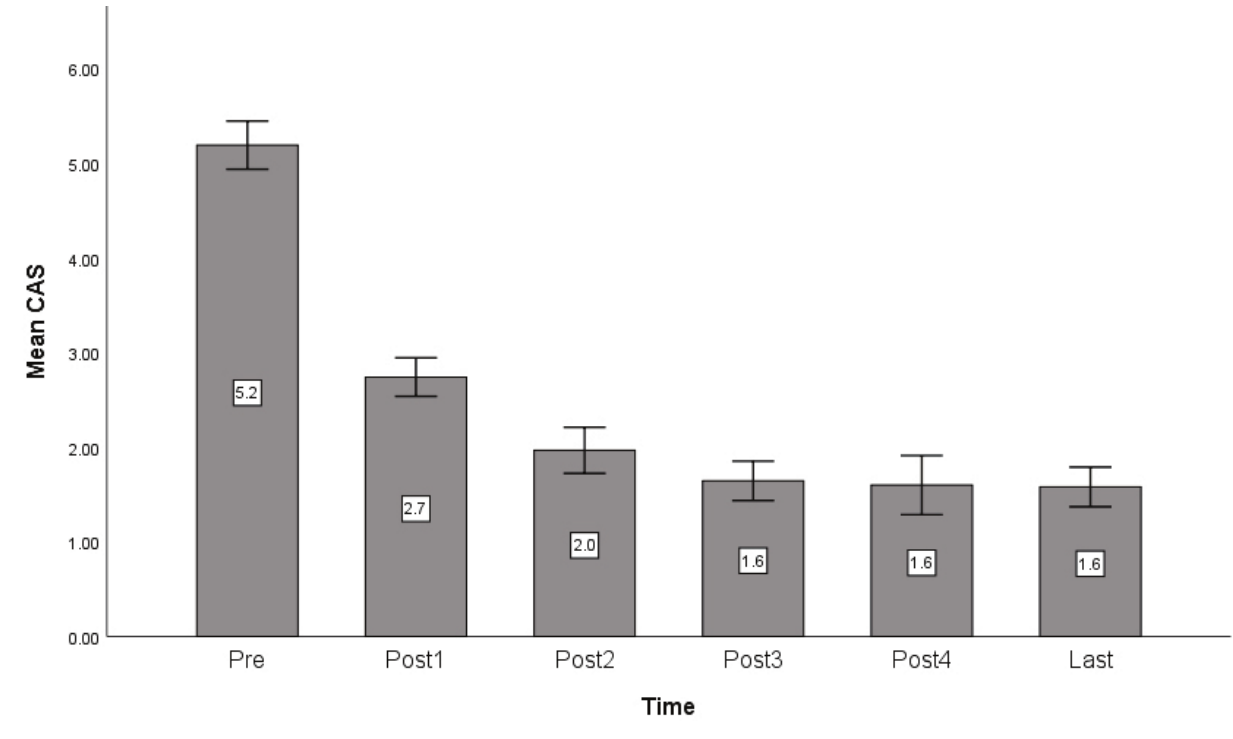
Figure 1. Bar diagram of changes in mean clinical activity score (CAS) before the injections up to the final examination.